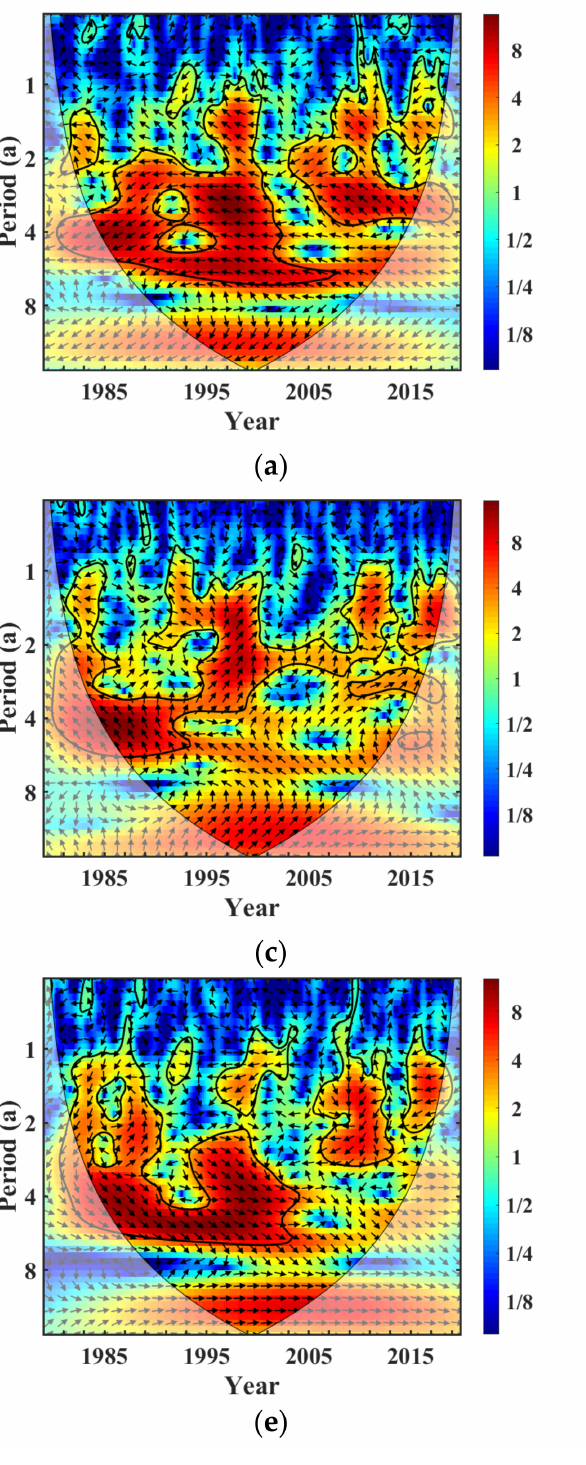
Figure 9. Correlations between the Oceanic Niño Index (ONI) and wind field principal components over the northern South China Sea. ( a , b ) First mode; ( c , d ) second mode; and ( e , f ) third mode. Left column: cross-wavelet transform. Right column: wavelet